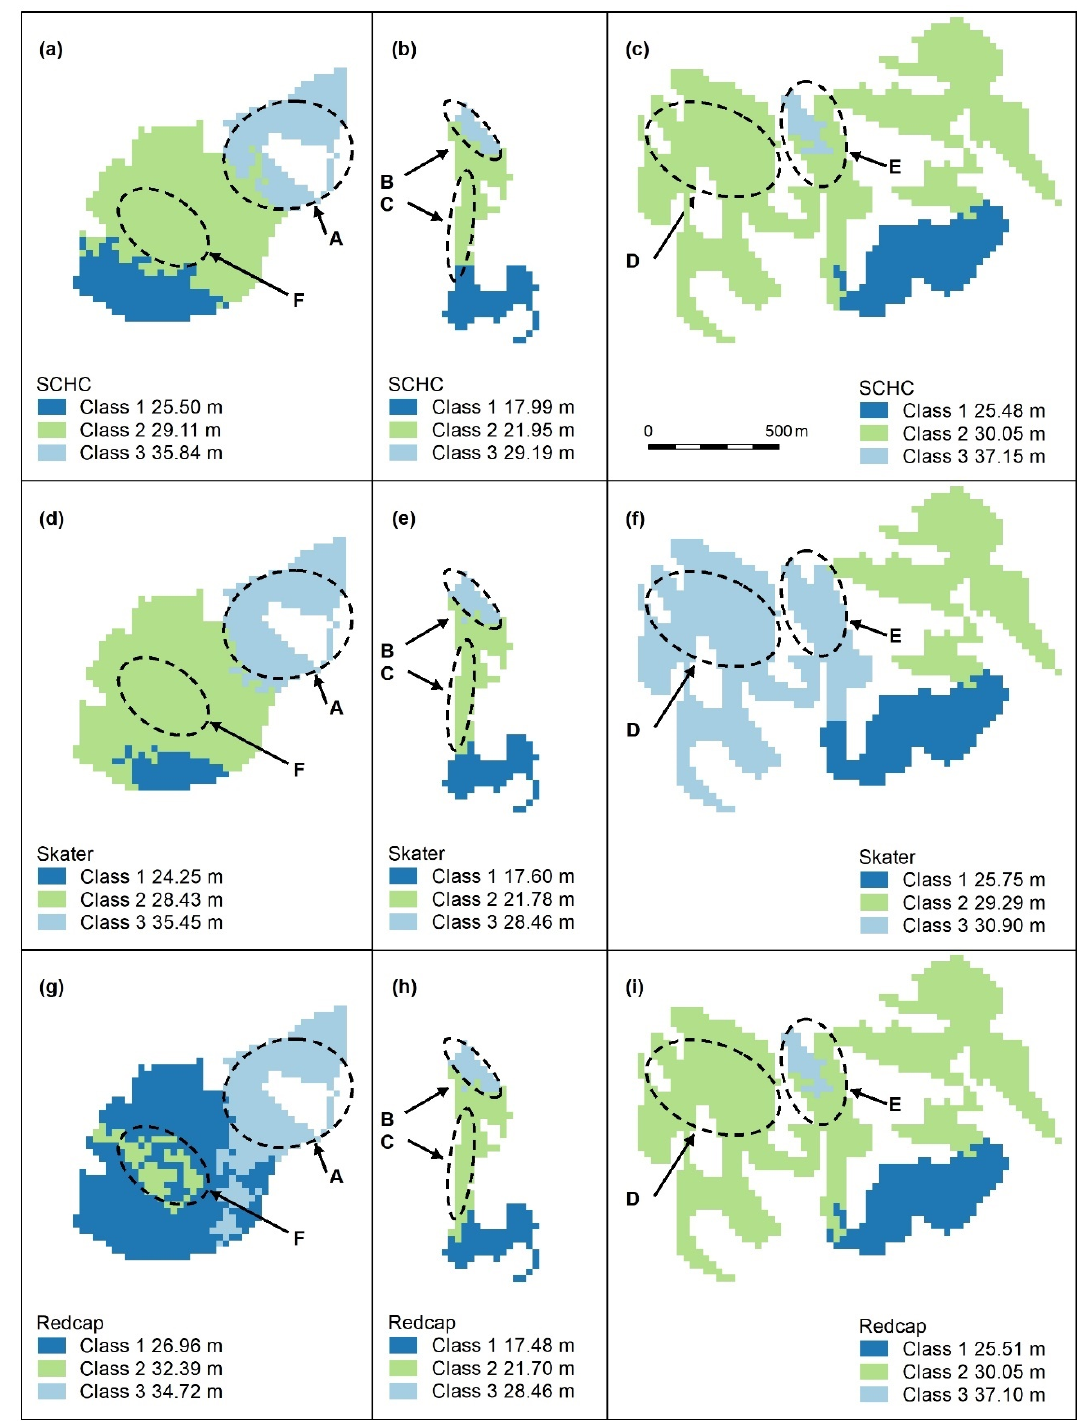
Figure A7. Spatially constrained hierarchical (SCHC, ( a – c ), Skater ( d – f ), and Redcap ( g – i )) clustering maps with 3 classes. Letters A–F indicate areas of higher canopy, features A and B are adequately captured by all algorithms, but the areal extent of E is too small ( c , i ) or too large ( f ). C and D are not recognised. Redcap ( g ) separates an area of regrowth forest on land previously used for farming (dark blue) adjoining a relatively undisturbed national park (light blue), which encompasses Feature A and recognises F, the unmapped area of Eucalyptus tereticornis . Panel scores: Hierarchical clustering = 7, Skater = 9, and Redcap = 9.